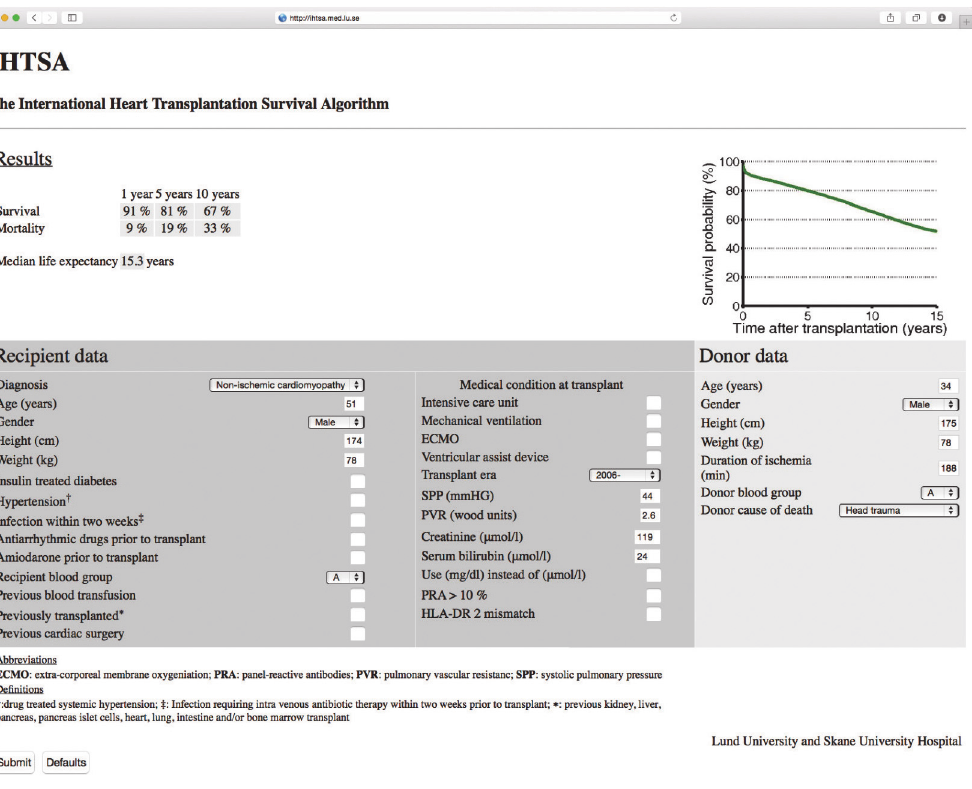
Fig 7. The International Heart Transplantation Survival Algorithm (IHTSA) as a web application. The IHTSA has been implemented as an interactive program that estimates median, 1-, 5-, and 10-year survival, and the benefit of adding (or removing) properties from an individual recipient and the potential donor (http://www.ihtsa.med.lu.se). ECMO, extracorporeal membrane oxygenation; HLA, human leukocyte antigen; PRA, panel reactive antibody; PVR, pulmonary vascular resistance; SPP, systolic pulmonary pressure. † Drug treated systemic hypertension. ‡ Infection requiring intra venous antibiotic therapy within two weeks prior to transplant. * Previous transplant —— previous kidney, liver, pancreas, pancreas islet cells, heart, lung, intestine and/or bone marrow